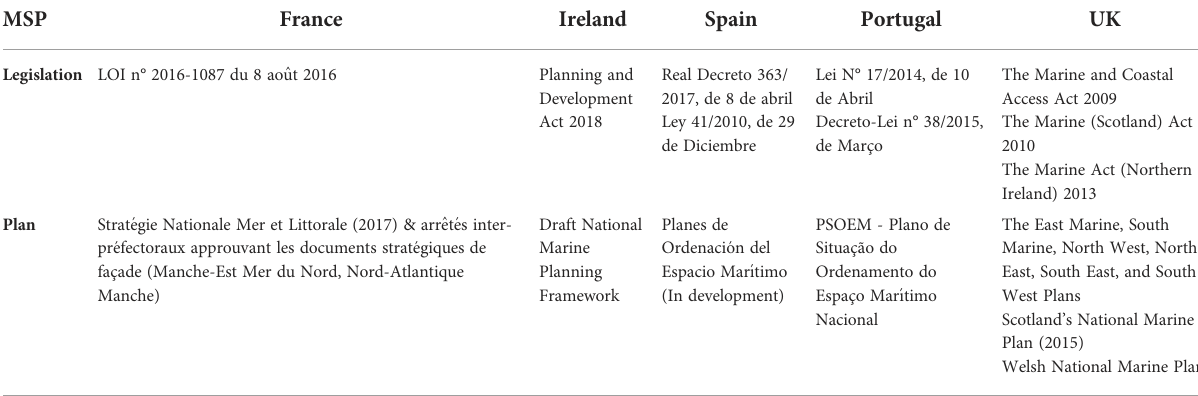
TABLE 1 Adopted legislation and MSP plans of the case studies.